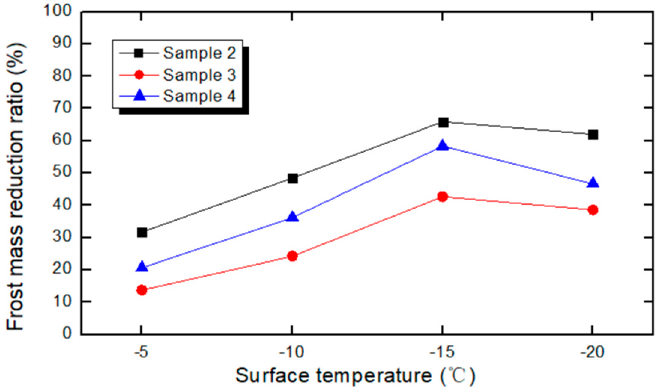
Figure 6. The frost mass reduction ratio of the nanoporous hydrophilic aluminum sheets under different surface temperatures, and at T a = 5 °C, φ = 60%.